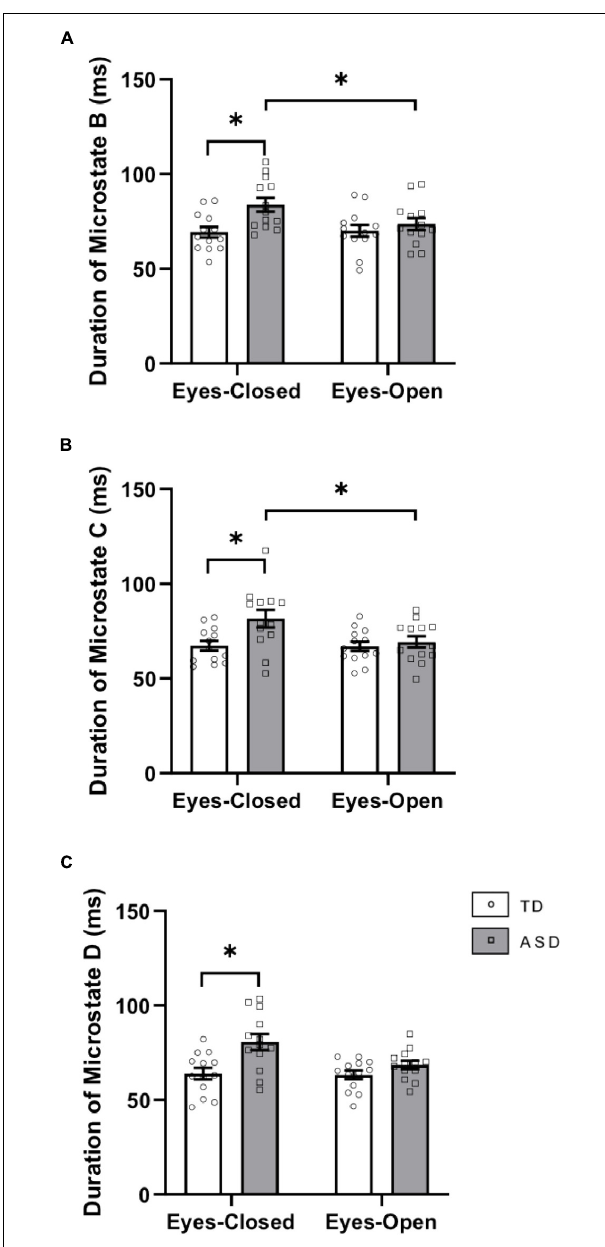
FIGURE 2 | Durations of (A) microstate class B, (B) microstate class C, and (C) microstate class D in EC and EO for the two groups. This graph displays the mean duration of each microstate with corresponding standard error of the mean. The white and gray bars display results from the TD and ASD groups, respectively. individual participant data is plotted on each bar. All significant differences are indicated with asterisks ( p < 0.0125, Bonferroni corrected).